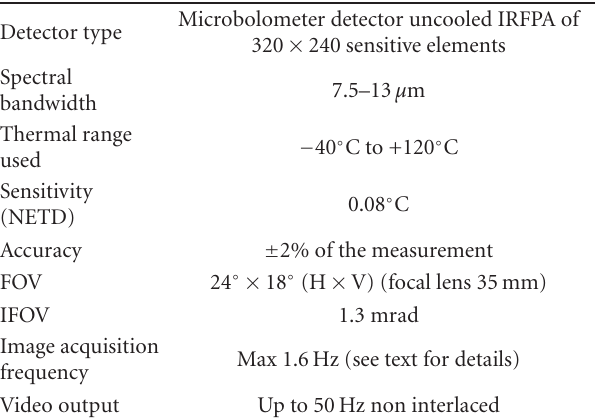
Table 2: Characteristics of FLIR S65